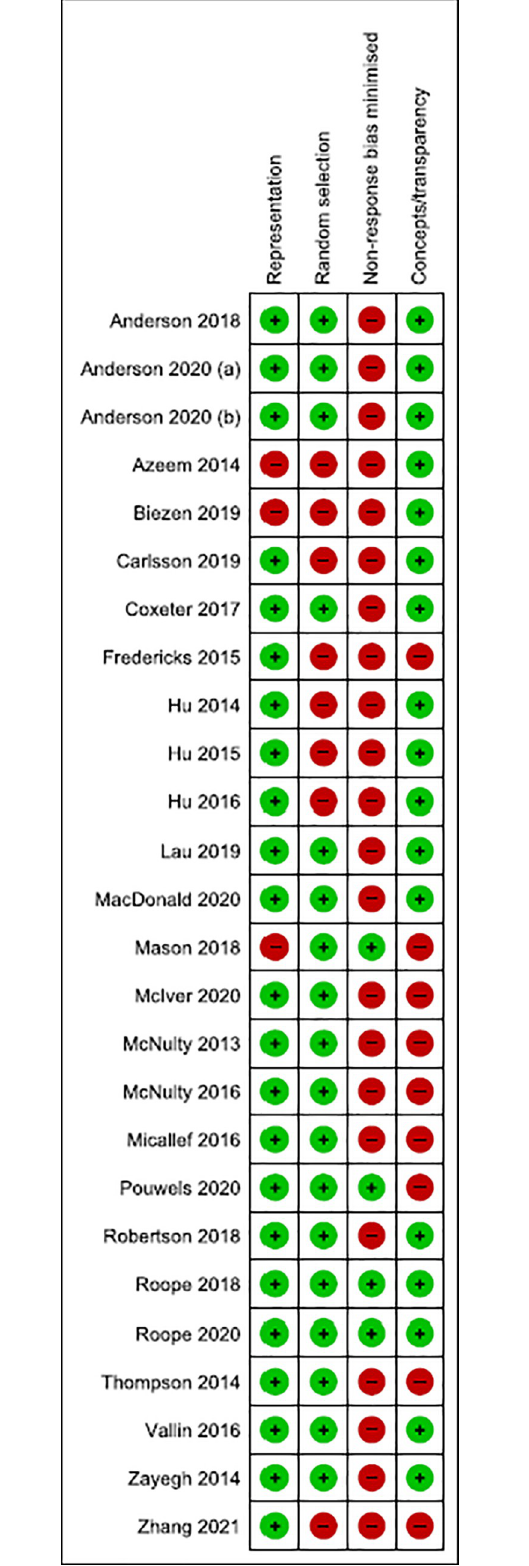
Fig 1. Risk of bias of the included